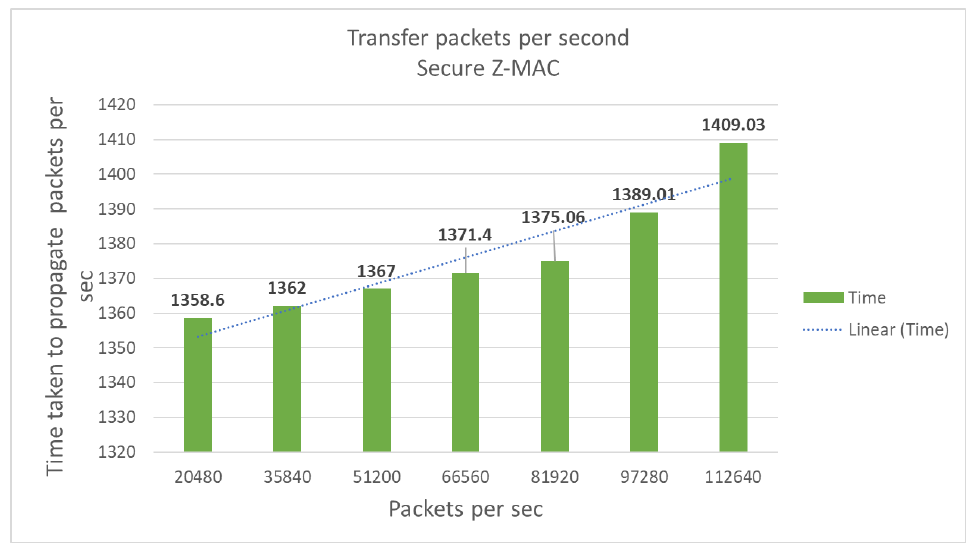
Figure 9. Total transmission time for nodes using the Z-MAC scheme along with the IHOP mechanism. Table 6. Total transmission time for nodes using the secure Z-MAC scheme. Nodes